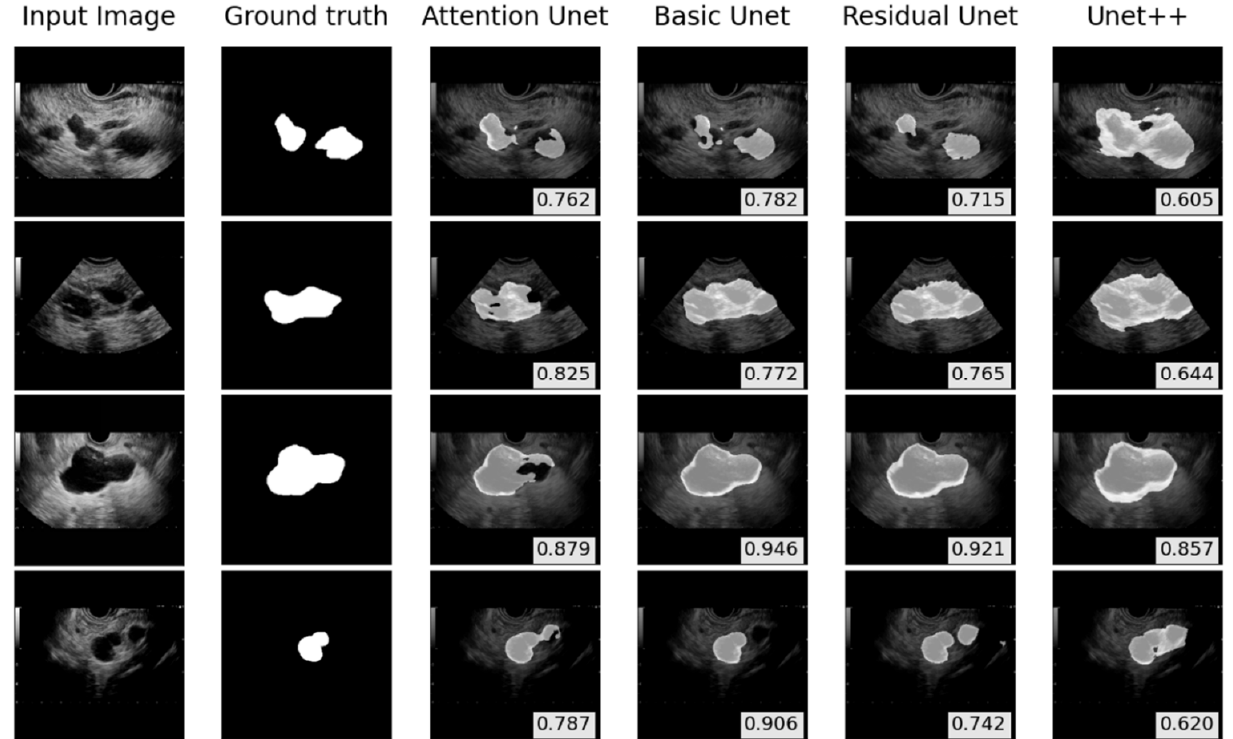
Figure 7. The performance of external test on pancreatic cyst lesions segmentation. The dice simi- larity coefficient scores are shown in the bottom-right